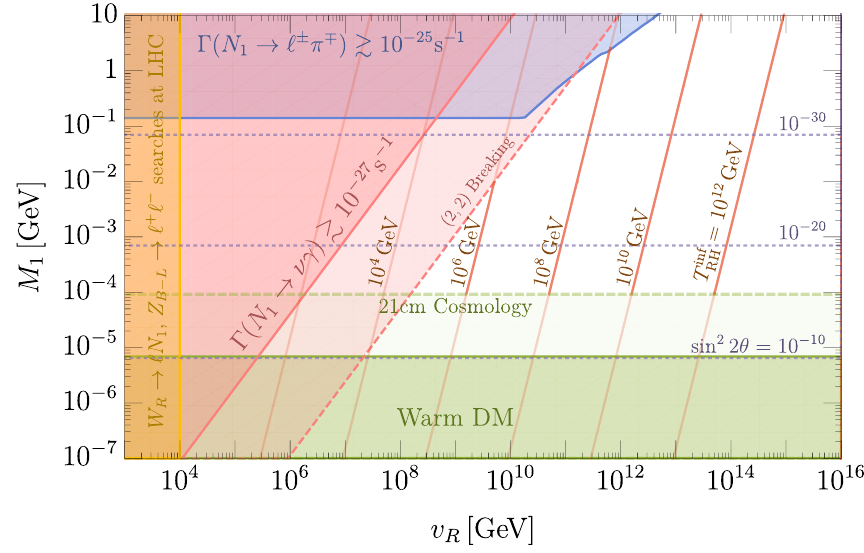
Figure 4 . The parameter space for N 1 DM produced by freeze-in. The observed relic abundance occurs in the unshaded region for values of T inf shown by the dashed red contours. Constraints RH from small scale structure are shown in green , with projections from future probes of small scale structure using the 21 cm line in dashed green . In the blue region N 1 decays too rapidly via W R to ‘ (cid:6) (cid:25) (cid:7) , and in the pink region N 1 decays too rapidly via W R (cid:0) W L mixing to (cid:23)(cid:13) when SU(2) L is broken by (2 ; 1) + (1 ; 2) (solid) or by (2 ; 2) (dashed). The decay via W R (cid:0) W L mixing to ‘ + ‘ (cid:0) (cid:23) is weaker and not shown. The horizontal dashed blue lines show the limit (3.4) on the mixing angle of N 1 with active neutrinos. Collider searches for W R exclude v R below about 10 TeV, as shown in orange